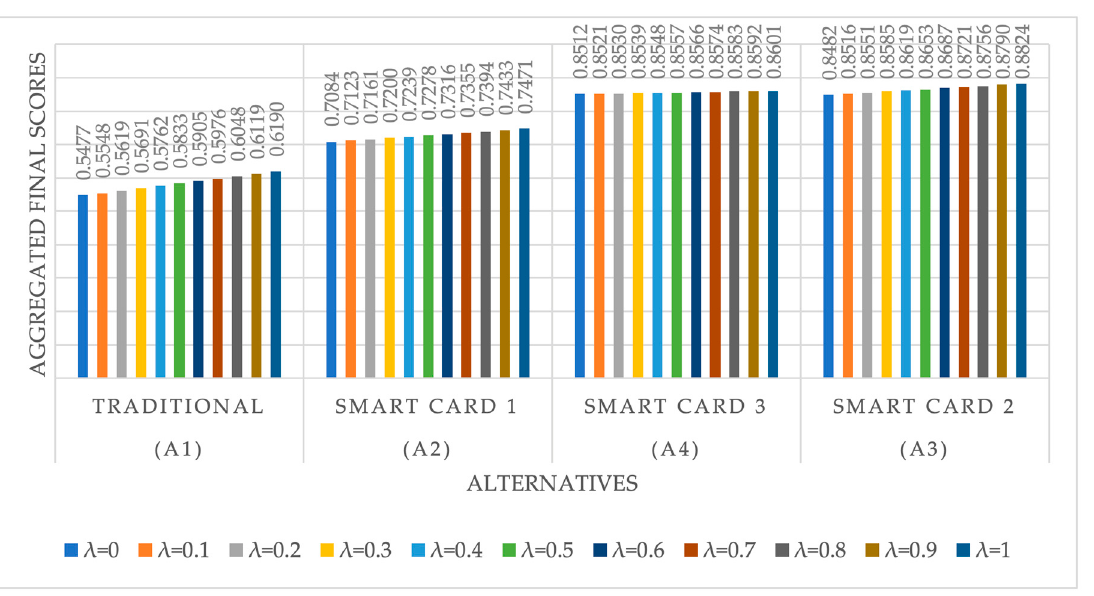
Figure 5. Final scores of alternatives.